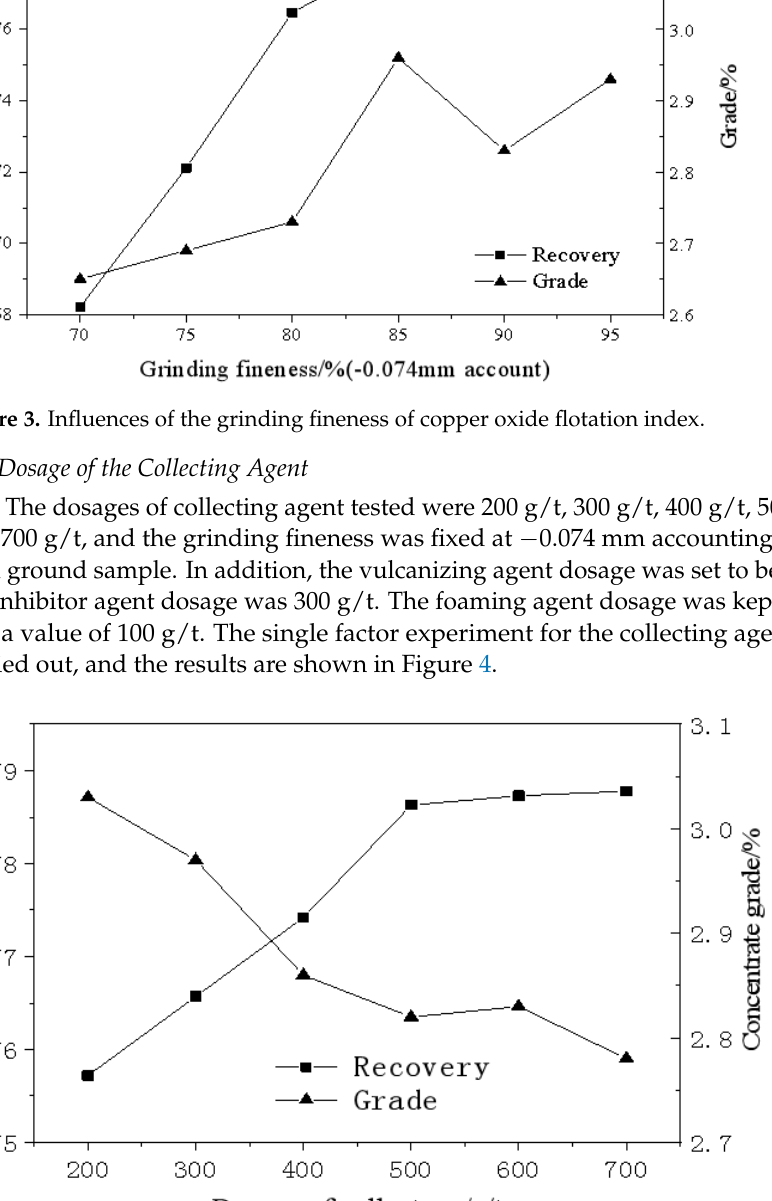
8min Figure 2. Flow chart of the two roughing-one scavenging mineral processing. 3. Results and Discussion Considering the low grade oxidized copper ore in Yunnan province (China), first, a single factor experiment was carried out to examine the changes in various factors that affect the flotation indices, and the amine activation effect of the ammonium salt was demonstrated. 3.1. Grinding Fineness First, under different grinding conditions, the minerals were examined for changes in flotation concentrate and recovery of copper grade. The ground particles finer than